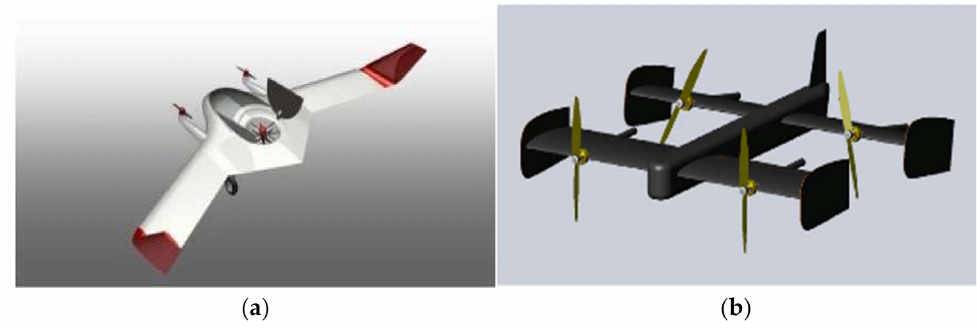
Figure 3. Examples of hybrid UAVs: ( a ) The TURAC VTOL UAV. Reprinted from [5], ( b ) The SUAVI quad tilt-wing UAV. Reprinted from [6].